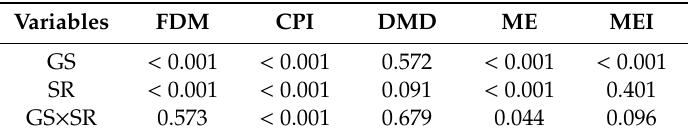
Table 2. The p –values of the e ff ects of grazing season, stocking rate, and their interactions on the digestive and metabolic indicators of Tibetan sheep.